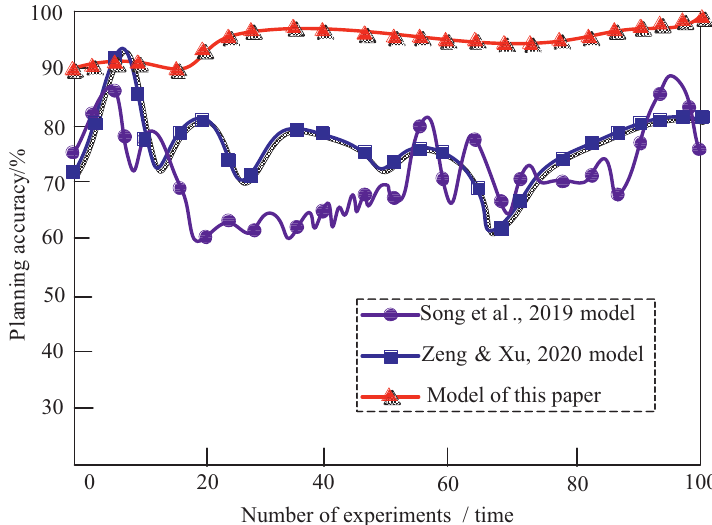
Figure 1. Comparison results of planning